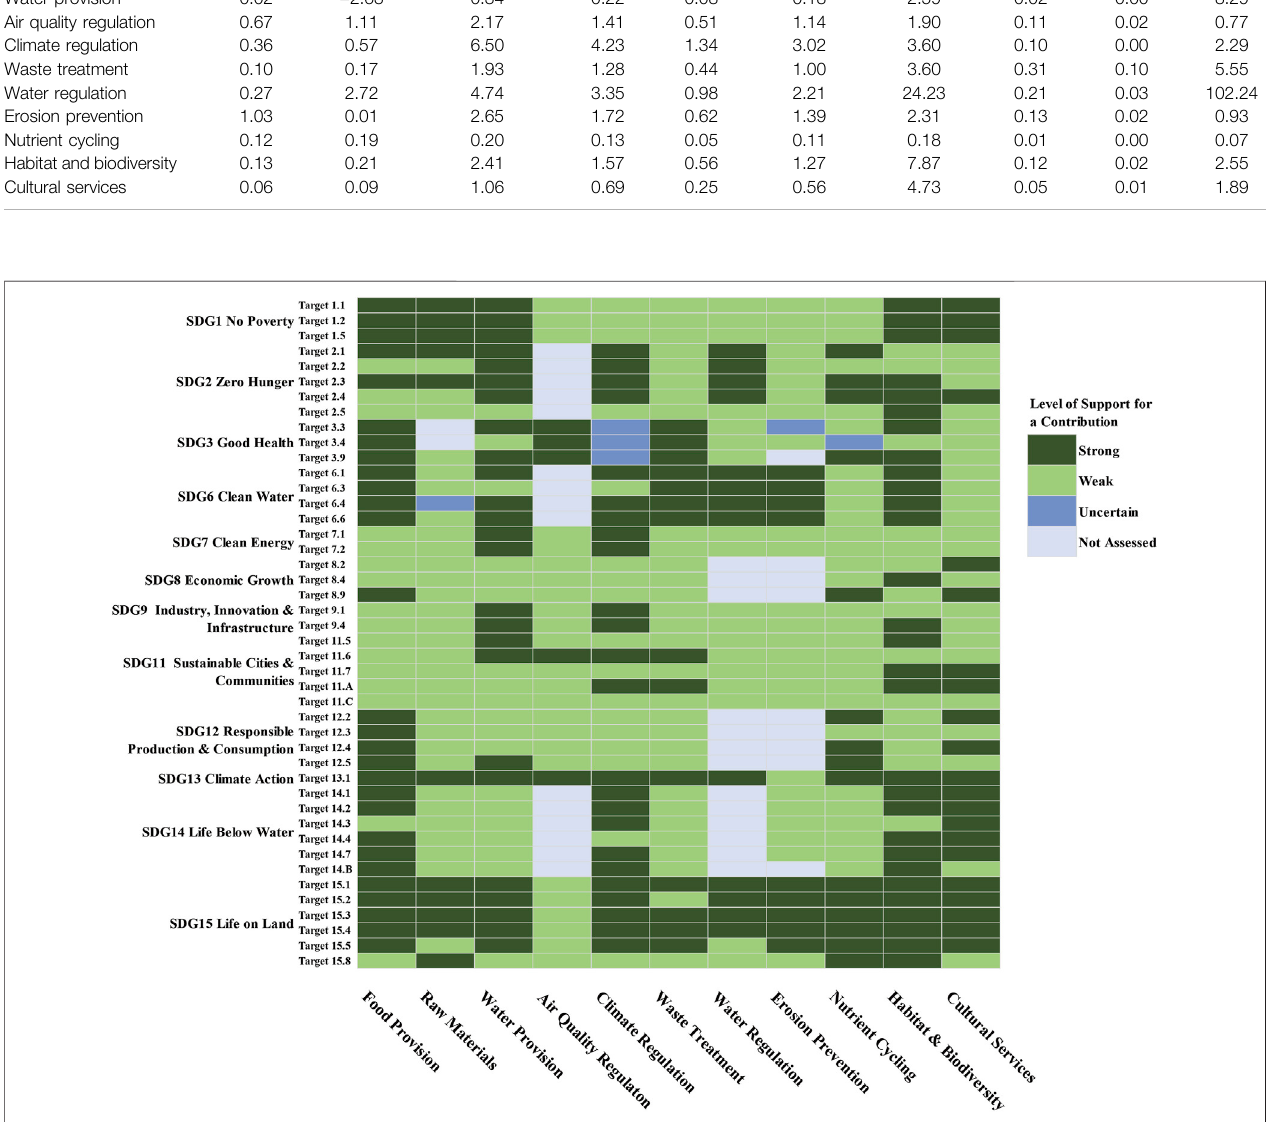
Frontiers in Environmental Science |